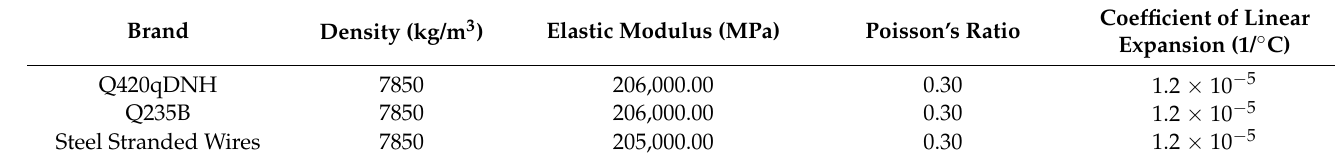
Table 5. Physical property parameters of